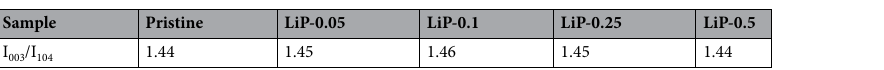
Sample Pristine LiP-0.05 LiP-0.1